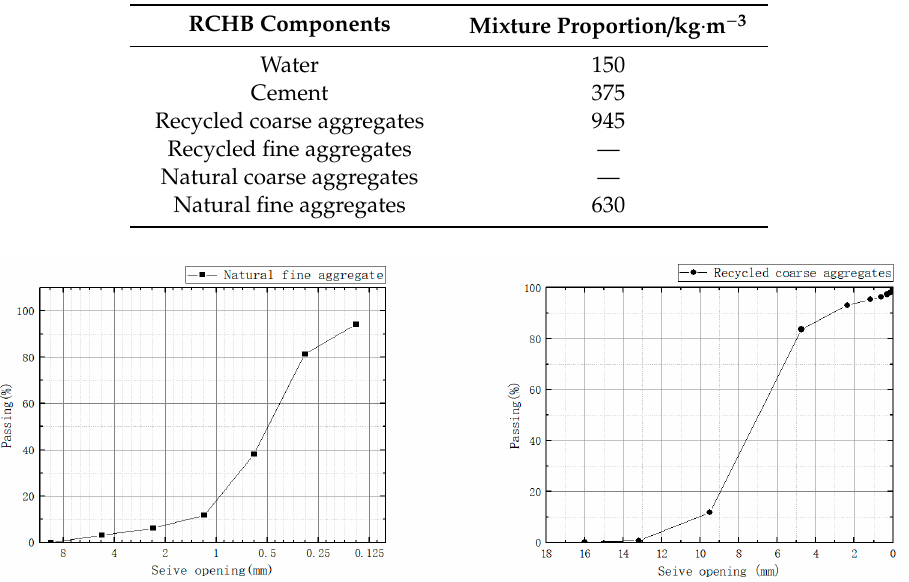
Figure 2. Fuller grading curves.